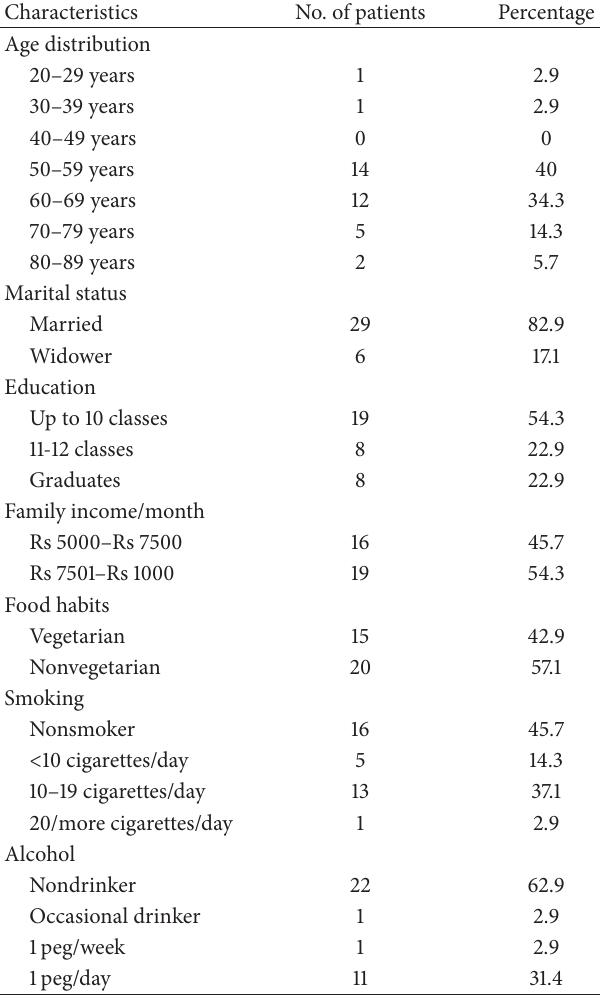
Table 1: Demographic characteristics and habits of the patients undergoing